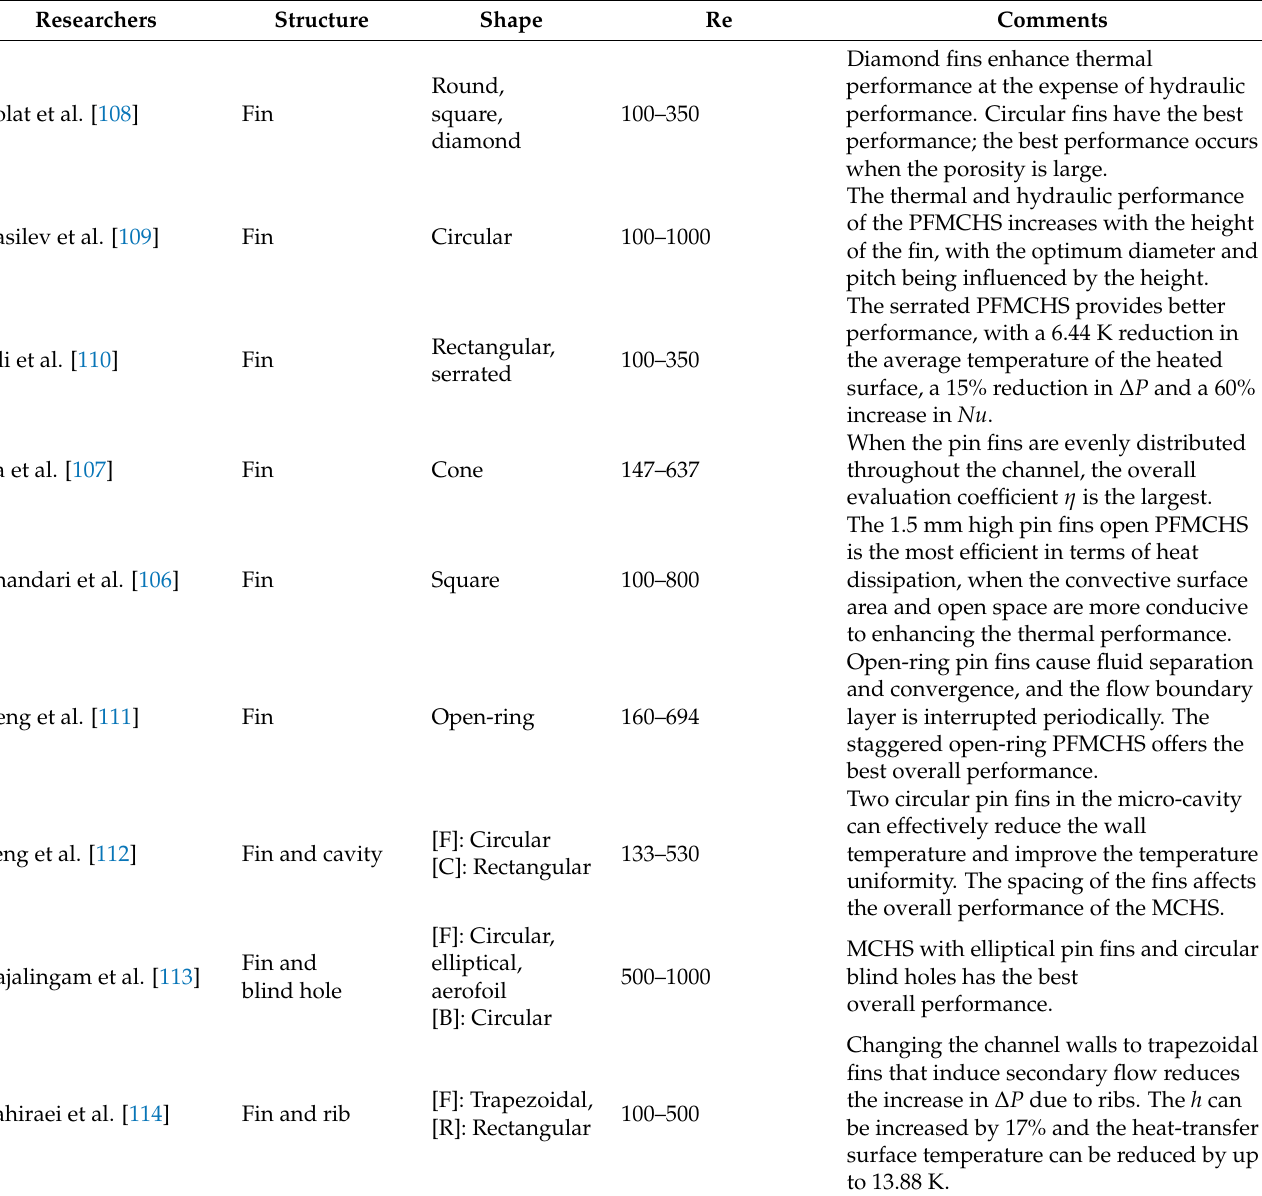
Table 5. The effect of pin fins on the thermal and hydrological performance of MCHS.